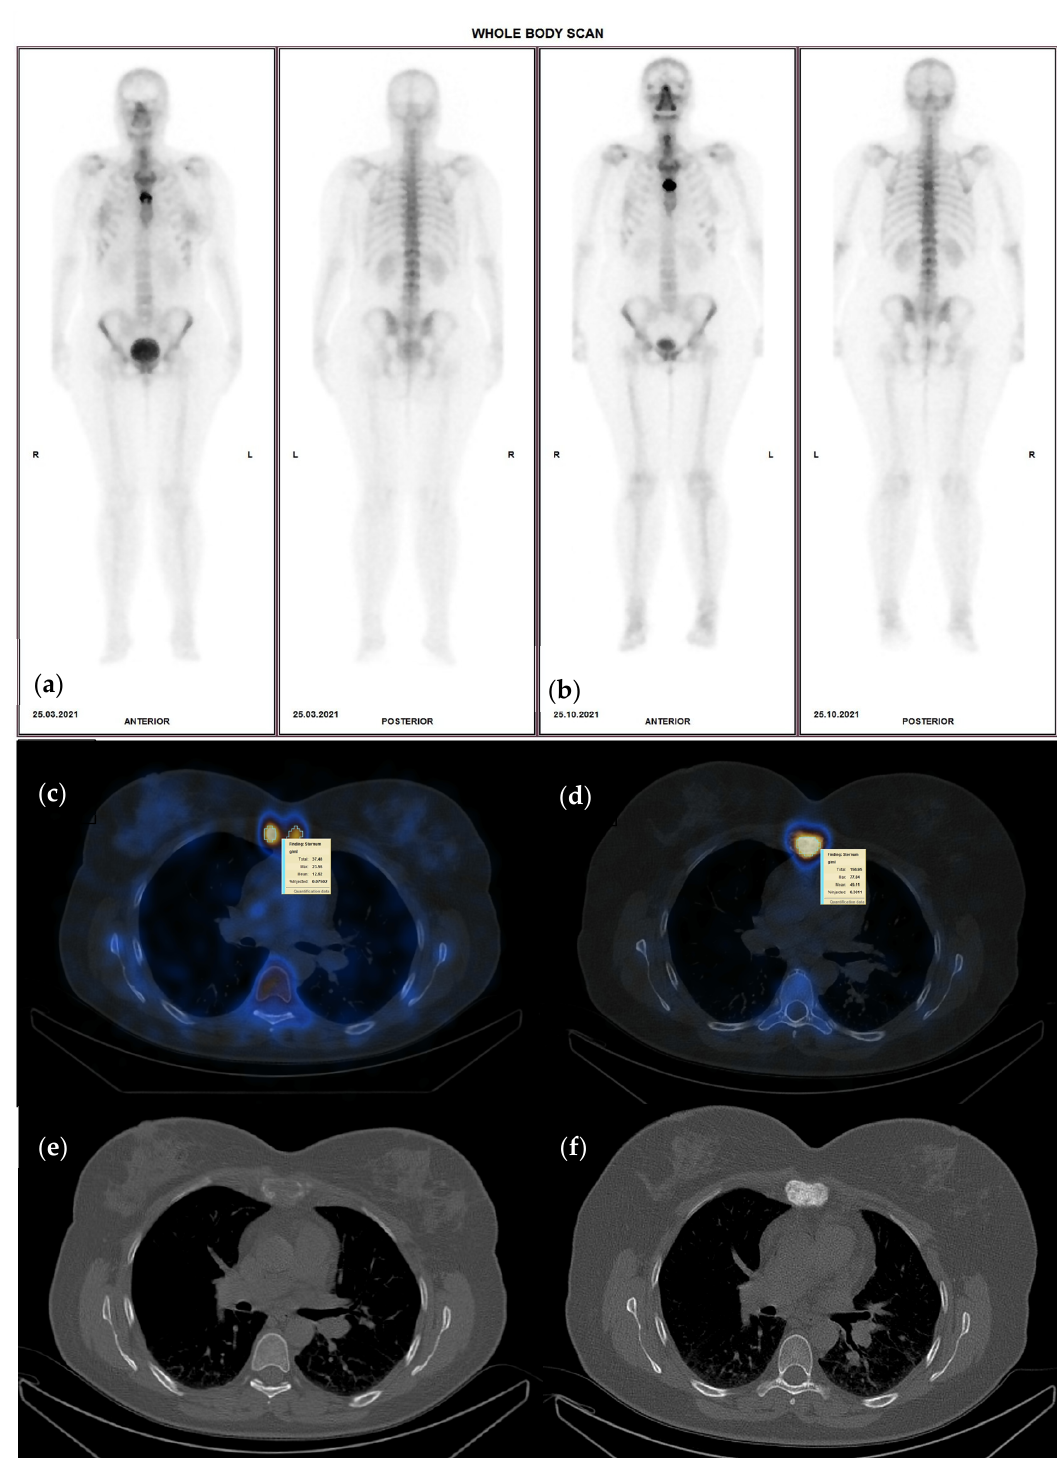
Figure 1. Sixty-nine-year-old female with invasive ductal carcinoma and surgical (right mastectomy), chemotherapy and hormone therapy treatment presenting with bone metastases, represented by high heterogenous radiotracer uptake on the sternum with an SUVmax of 23.5 g/mL ( a )—WBS and ( c )—hybrid image corresponding to an osteolytic lesion on CT—( e ), on the baseline study; ( b )—WBS, ( d )—hybrid image of the follow-up SPECT-CT after 8 months of osteoclast inhibitor treatment, presenting higher radiotracer uptake (SUVmax of 77.8 g/mL) although the lesion became osteoblastic on the CT scan ( f